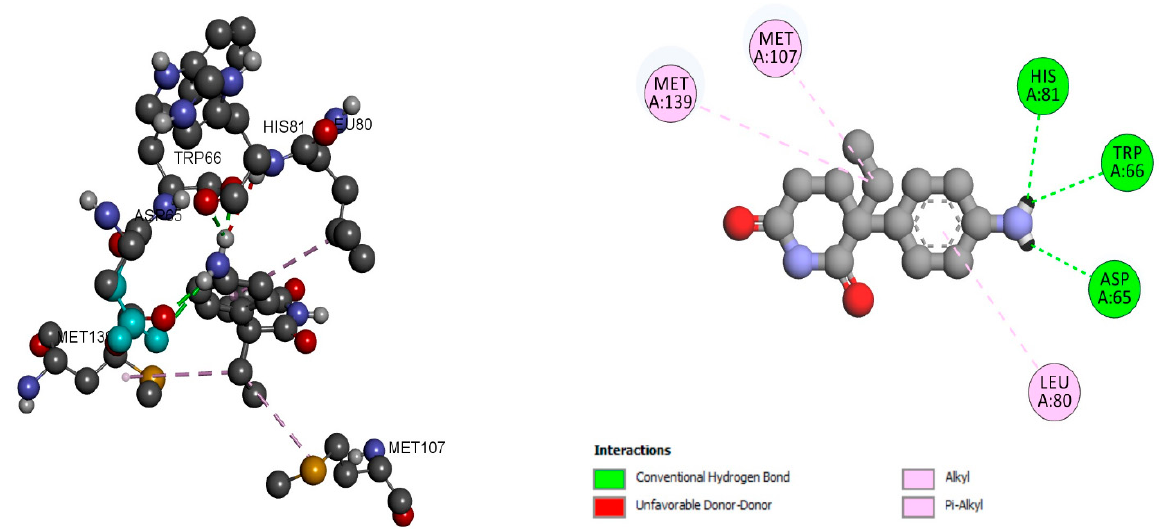
Figure 2. SHBG molecular interaction pattern with dihydrotestosterone.